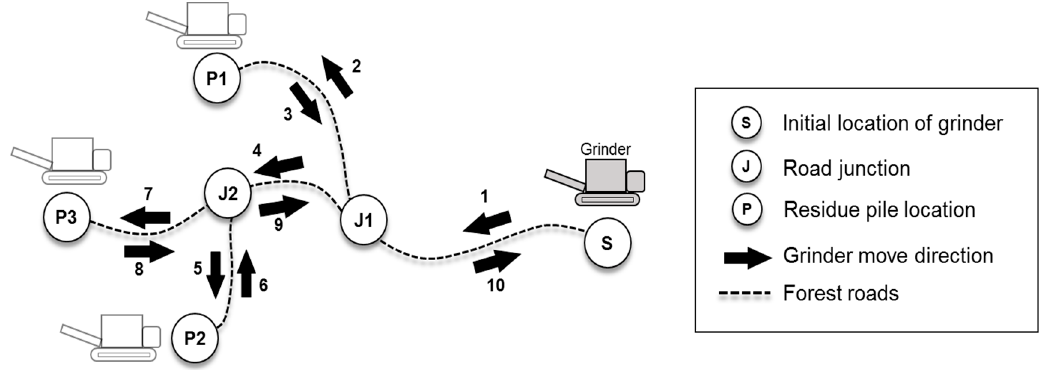
Figure 4. An example illustrating machine (e.g., grinder) mobilization for a hierarchical, tree-shaped road network. The numbered arrows indicate the move sequence and direction of the grinder as it visits each pile location for processing.